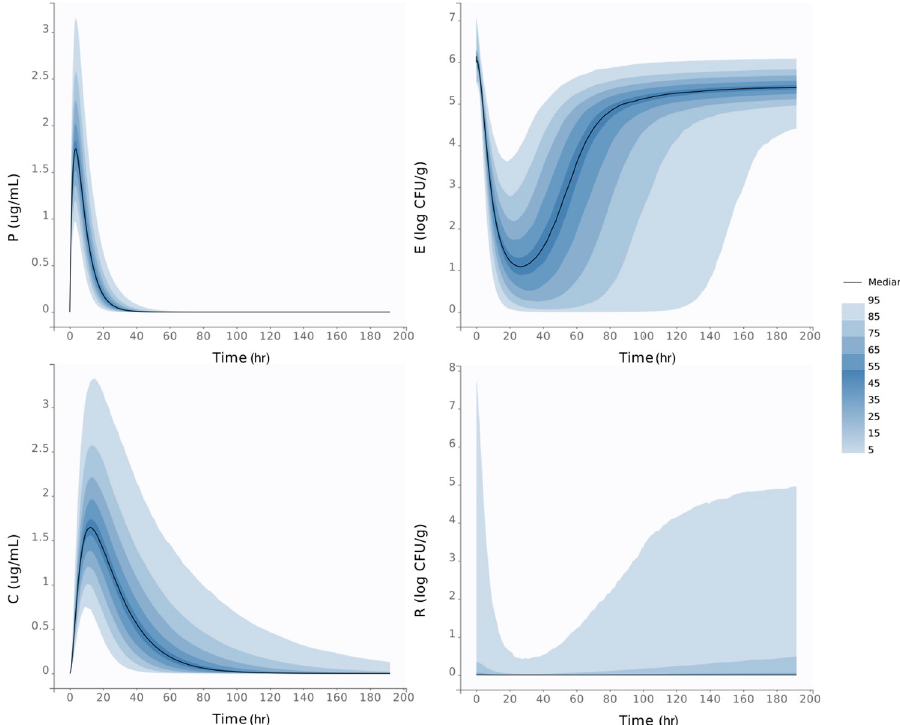
Fig 4. High dose distributions. Predicted distribution of our model for the antimicrobial drugs concentration throughout the GIT of the steer during the high dosing regimen. The top left panel is the plasma, the bottom left is the colon, top right the total E. coli population and bottom right is E. coli above the ECOFF. In each panel, the dark line represents the median, and the darkest blue region has a 50% likelihood, whereas the lighter colors are less likely to